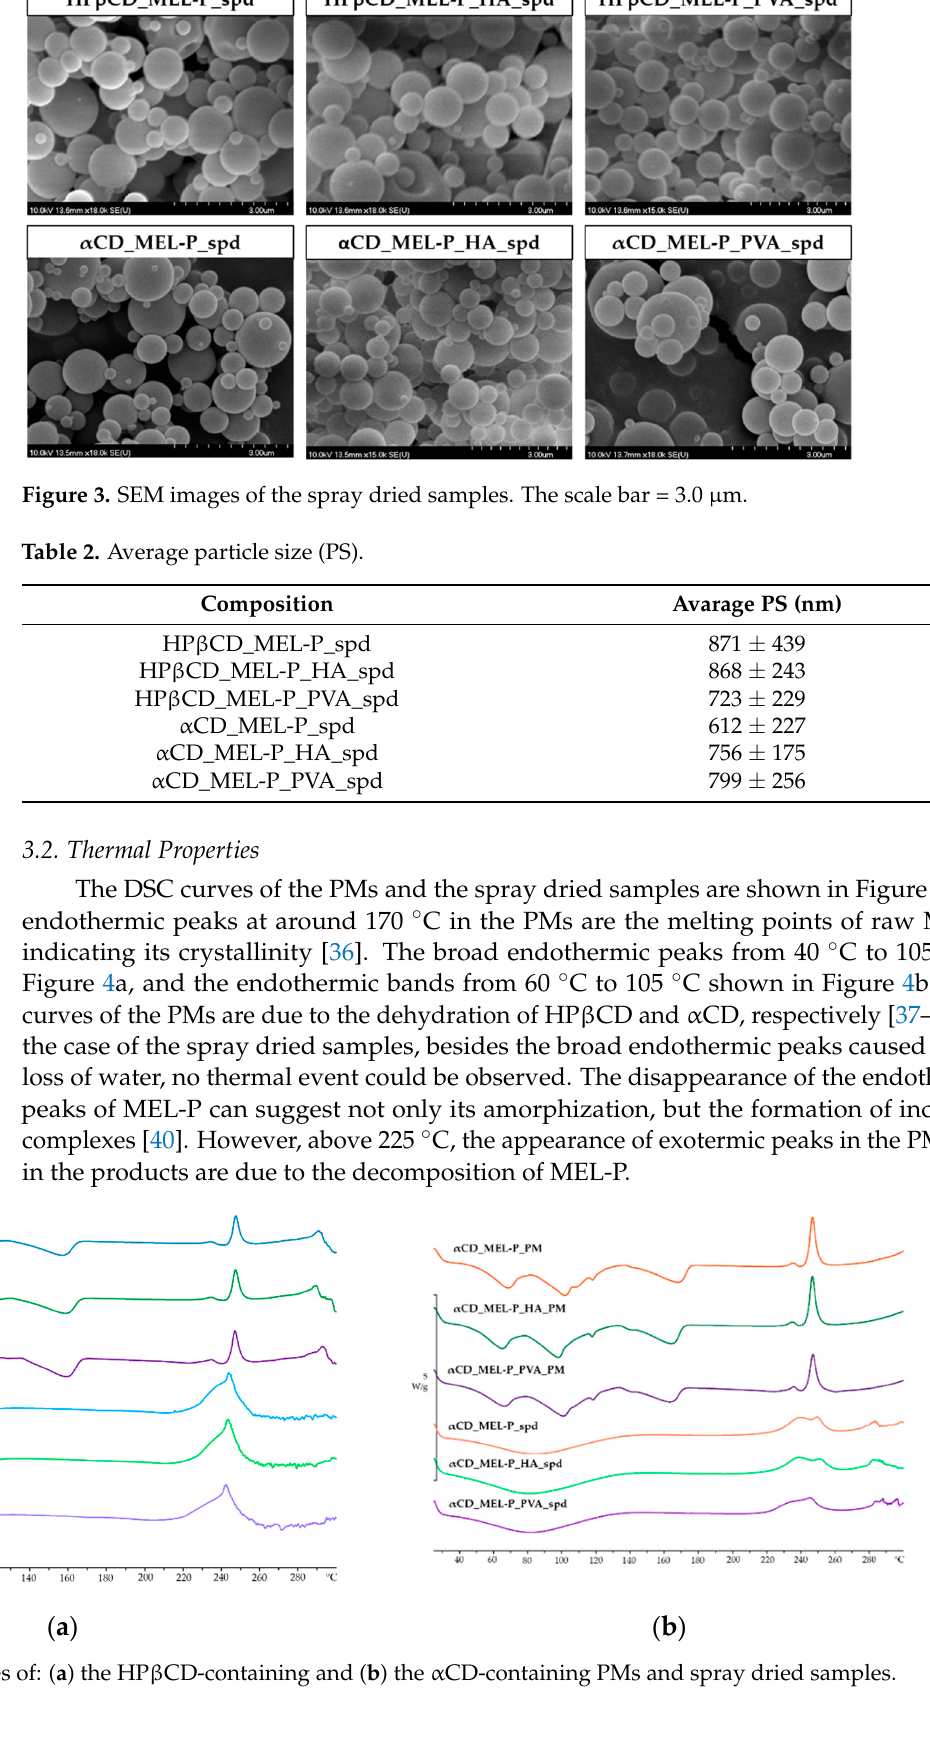
Figure 4. DSC curves of: ( a ) the HP β CD-containing and ( b ) the α CD-containing PMs and spray dried samples .